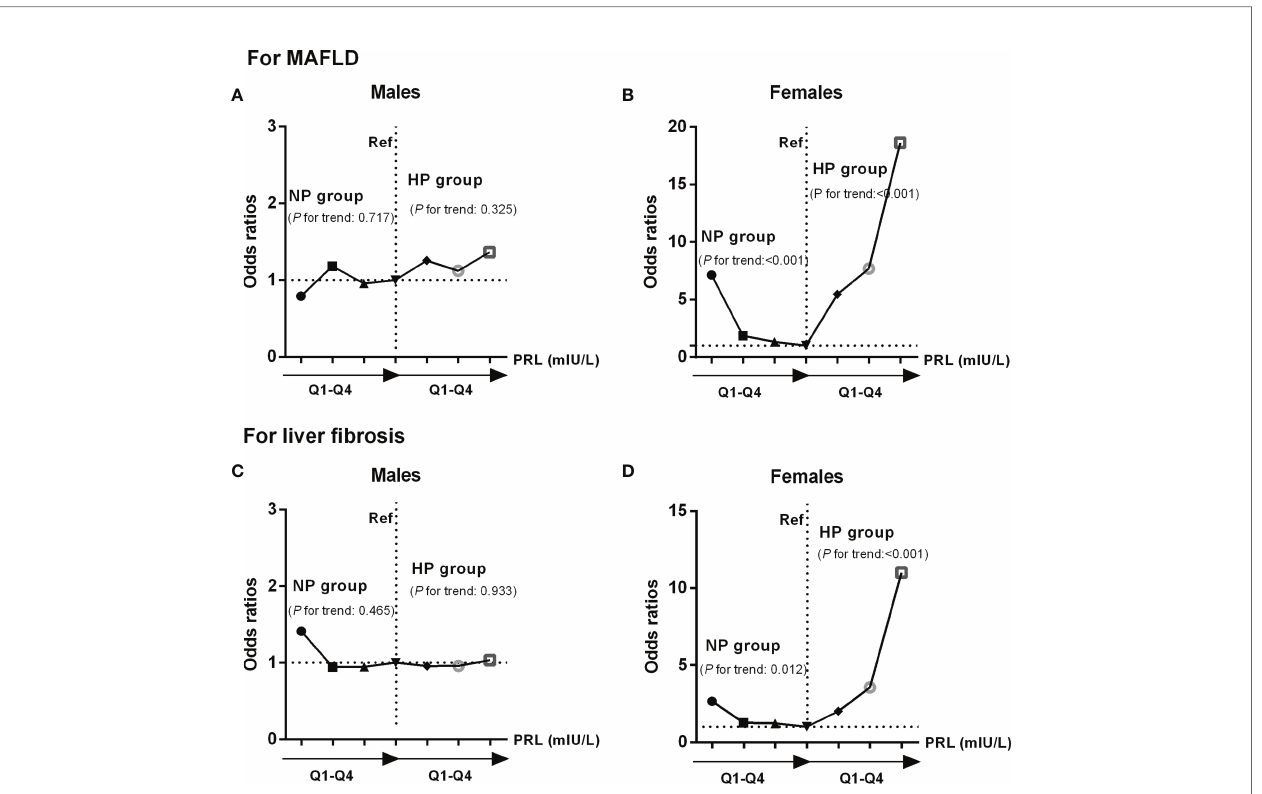
FIGURE 6 | Odds ratios (ORs) and 95% con fi dence intervals (CI) for MAFLD and liver fi brosis according to serum PRL quartiles: results of binary logistic regression analysis. PRL levels were plotted into four quartiles (Q1, Q2, Q3, and Q4) in both genders. Among females, there was a signi fi cant J-shaped association between serum PRL and risk of MAFLD ( P -trend < 0.001) (B) , as well as liver fi brosis ( P- trend < 0.05) across serum PRL quartiles (D) . In contrast, such association was not shown in males ( P -trend > 0.05) (A, C) . P -values <0.05 were accepted as statistically signi fi